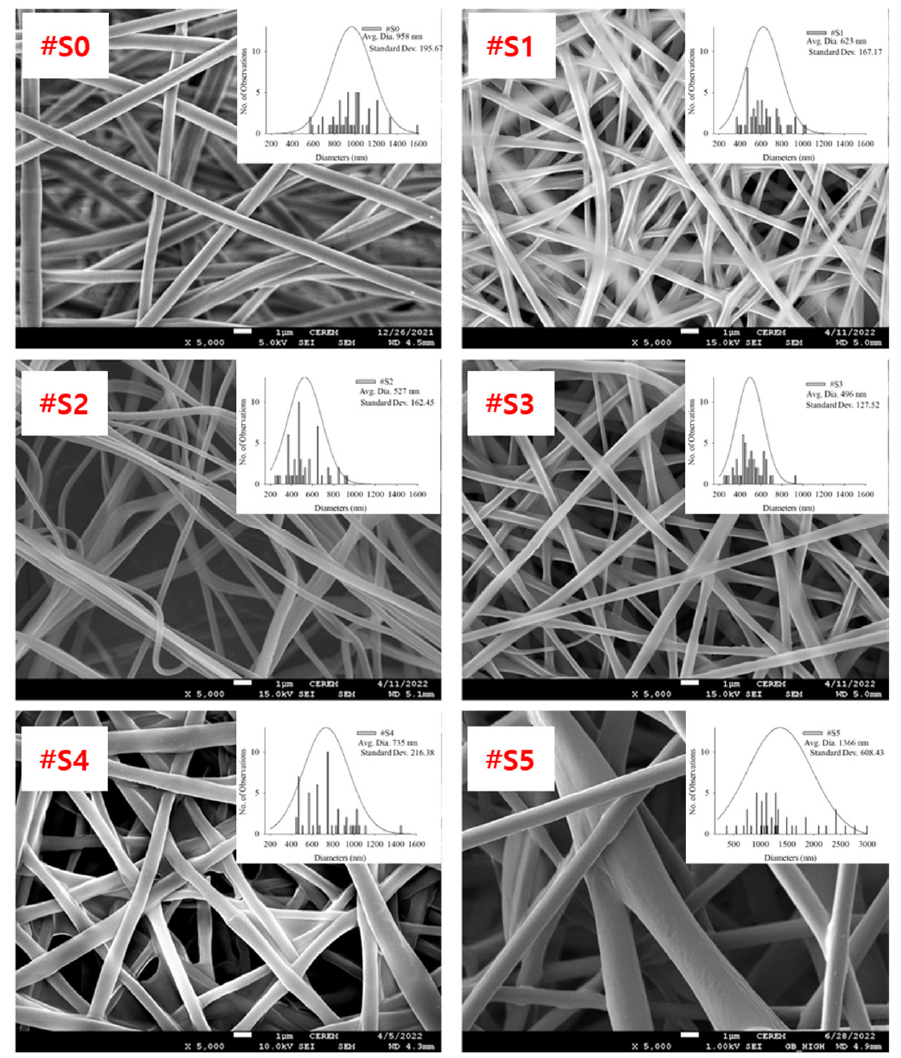
Figure 3. FE-SEM images, average diameters, and diameter distributions of (#S0), (#S1), (#S2), (#S3), (#S4), and (#S5).